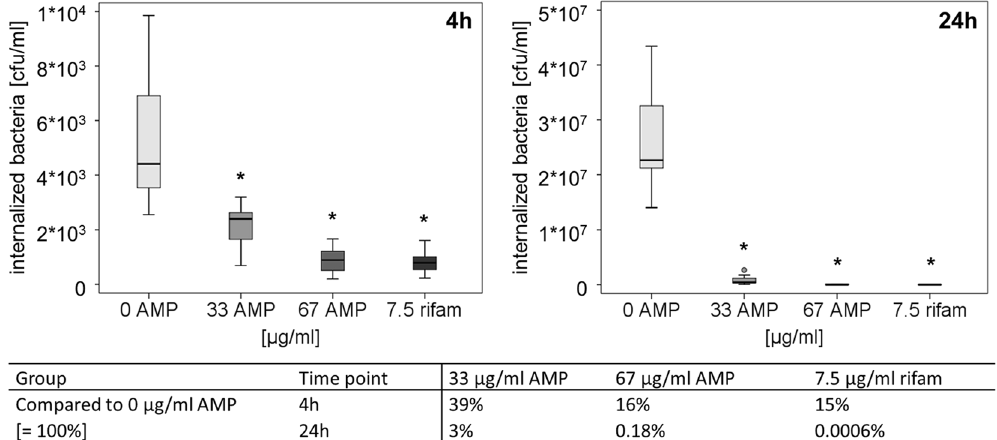
Figure 5. S. aureus internalized in human primary osteoblast-like cells were treated with 33 or 67 µ g/ml AMP2 and 7.5 µ g/ml rifampicin (rifam) for 4 hours and 24 hours (n = 7, cells from one donor). Data are shown as median with 25 and 75 percentiles. Kruskal-Wallis, Mann-Whitney, Bonferroni-Holm post-hoc test: * Significant compared to control group (0 µ g/ml AMP), p ≤